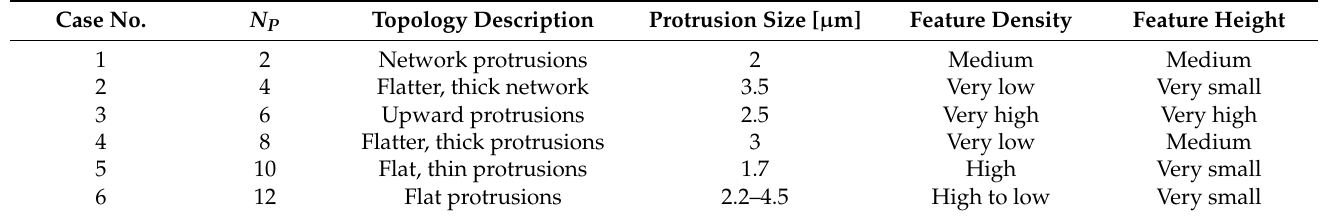
Table 2. Topology variation for spot-by-spot laser processing with 4 mm spot size.